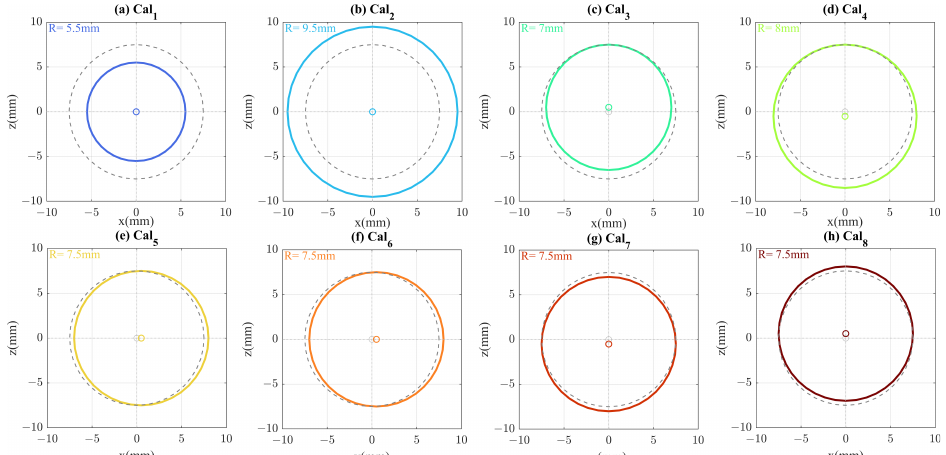
Figure 3. Different perturbations in the calibration sphere are shown: ( a , b ) calibration ROC variation, fixed COC, ( c , d ) calibration ROC variation, fixed apex, ( e , f ) calibration transverse misalignment, and ( g , h ) calibration axial misalignment. Correct calibration (Cal 0 ) is plotted with a dashed grey line and compared with different perturbation scenarios. Its COC and ROC coincide with the